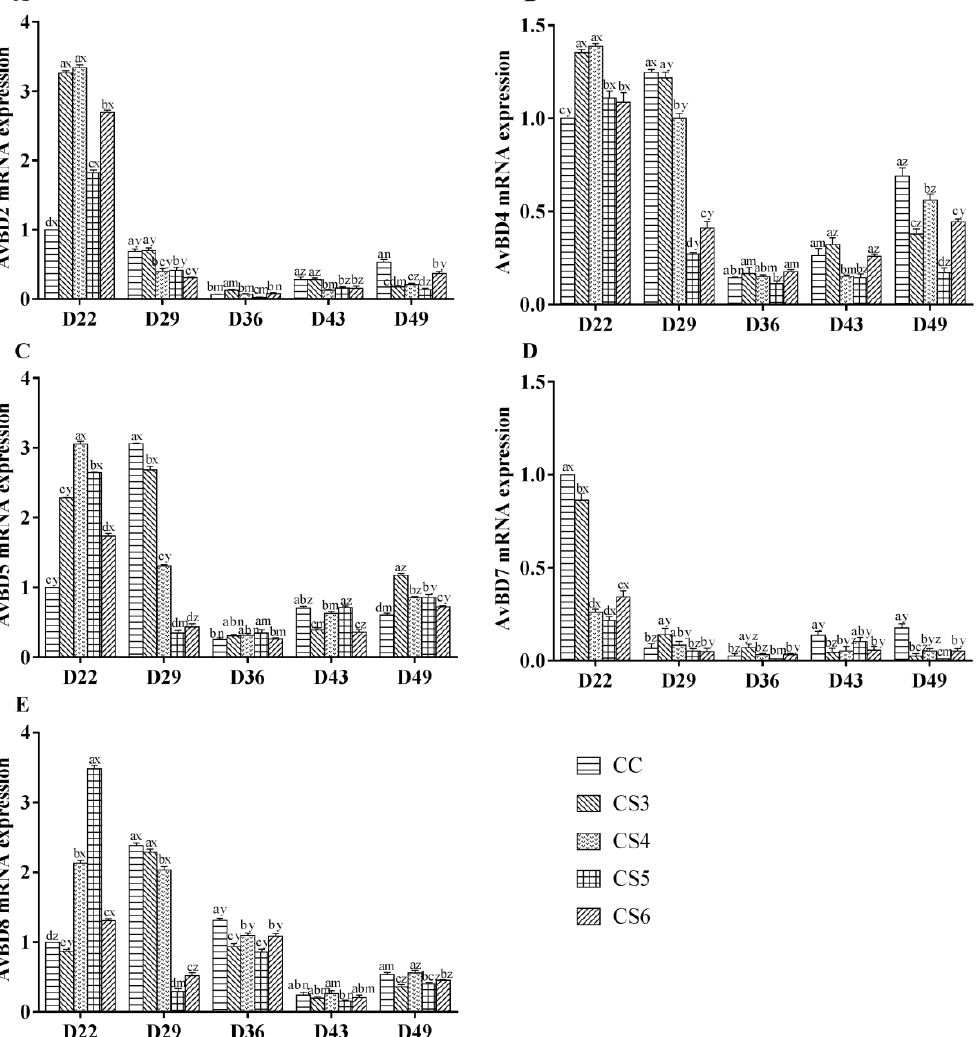
Figure 3. The mRNA expression levels of AvBD2 ( A ), AvBD4 ( B ), AvBD5 ( C ), AvBD7 ( D ), and AvBD8 ( E ) in broiler bursae of Fabricius at D22, D29, D36, D43, and D49 (where D denotes “days of age” and the numeral indicates the day number, e.g., D22 refers to 22 days of age). a, b, c, d, and e represent significant differences among groups at the same sampling time ( p < 0.05). x, y, z, m, and n represent significant differences among different sampling time in the same group ( p < 0.05). CS3, CS4, CS5, and CS6 refered to the intermittent and mild cold stimulation of 3°C below the conventional feeding temperature for three-, four-, five-, or six-hour periods at one-day intervals, respectively.